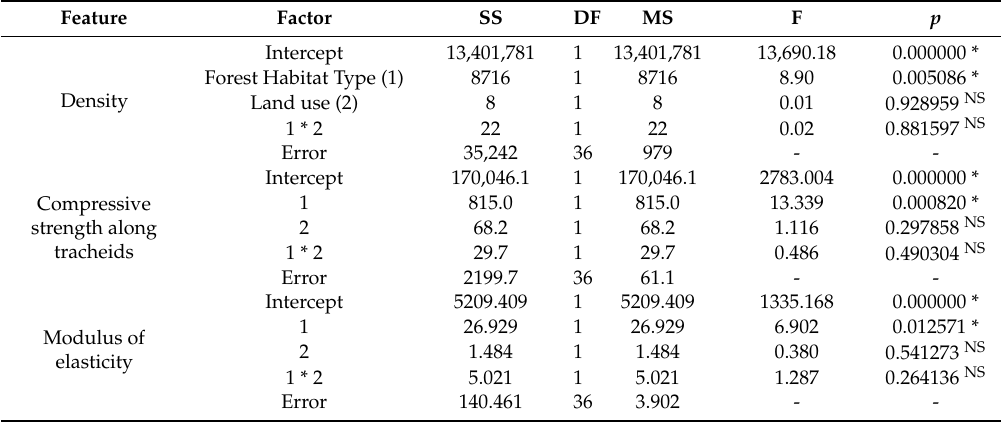
Table 7. Values of ANOVA for selected wood density mechanical properties depending on the forest type and